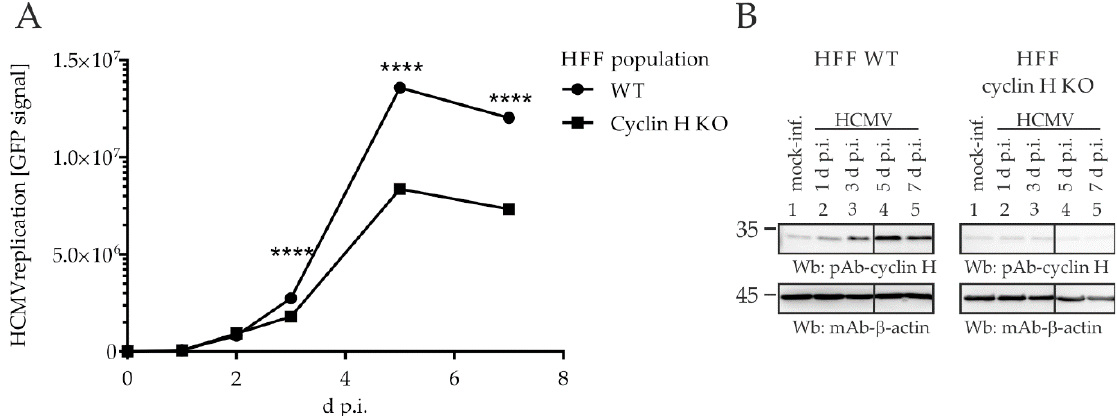
Figure 8. HCMV AD169-GFP replication kinetics in HFF WT and in transiently transduced HFFs with a partial level of cyclin H KO. A total of 225,000 HFFs were seeded in 12-well plates. The next day, cells were incubated with lentiviral supernatant for 24 h, introducing the CRISPR/Cas9 system and a cocktail of cyclin H-specific gRNAs for transient transduction. Subsequently, cells were incubated with fresh medium for 24 h. Next, HFF WT and cyclin H KO populations were infected with HCMV AD169-GFP at an MOI of 0.5 and harvested at the indicated time points. ( A ) Cells were lysed and the GFP signal of lysates was measured in triplicate using a Victor multilabel reader. Statistical analysis was performed using an ordinary two-way ANOVA and post-hoc Sidak correction; ****, p < 0.0001. ( B ) For comparison of intracellular cyclin H expression levels, the total cellular lysates used for GFP signal quantitation were subsequently denatured at the indicated time points and used for standard SDS-PAGE and Wb analysis. Cyclin H and β -actin were detected using specific antibodies as indicated.